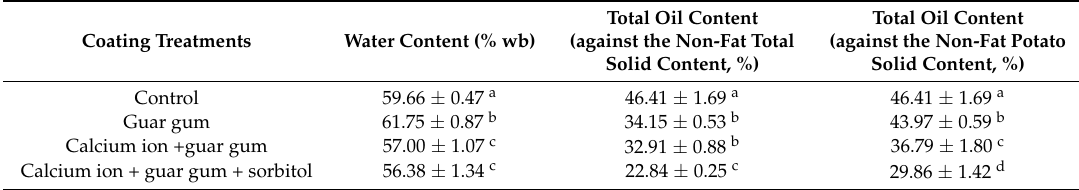
Table 2. Effects of coating treatments on water content and total oil content